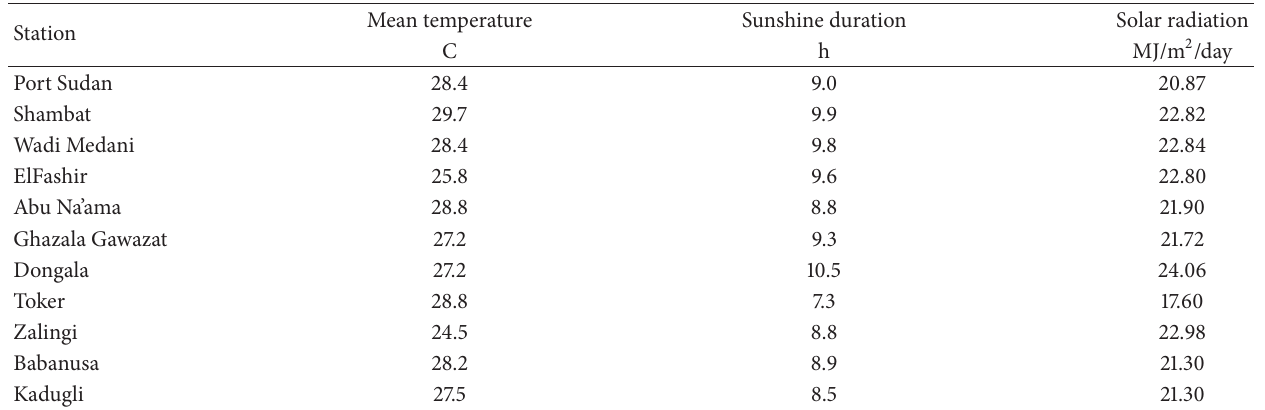
Table 7: Solar radiation and sunshine duration in Sudan